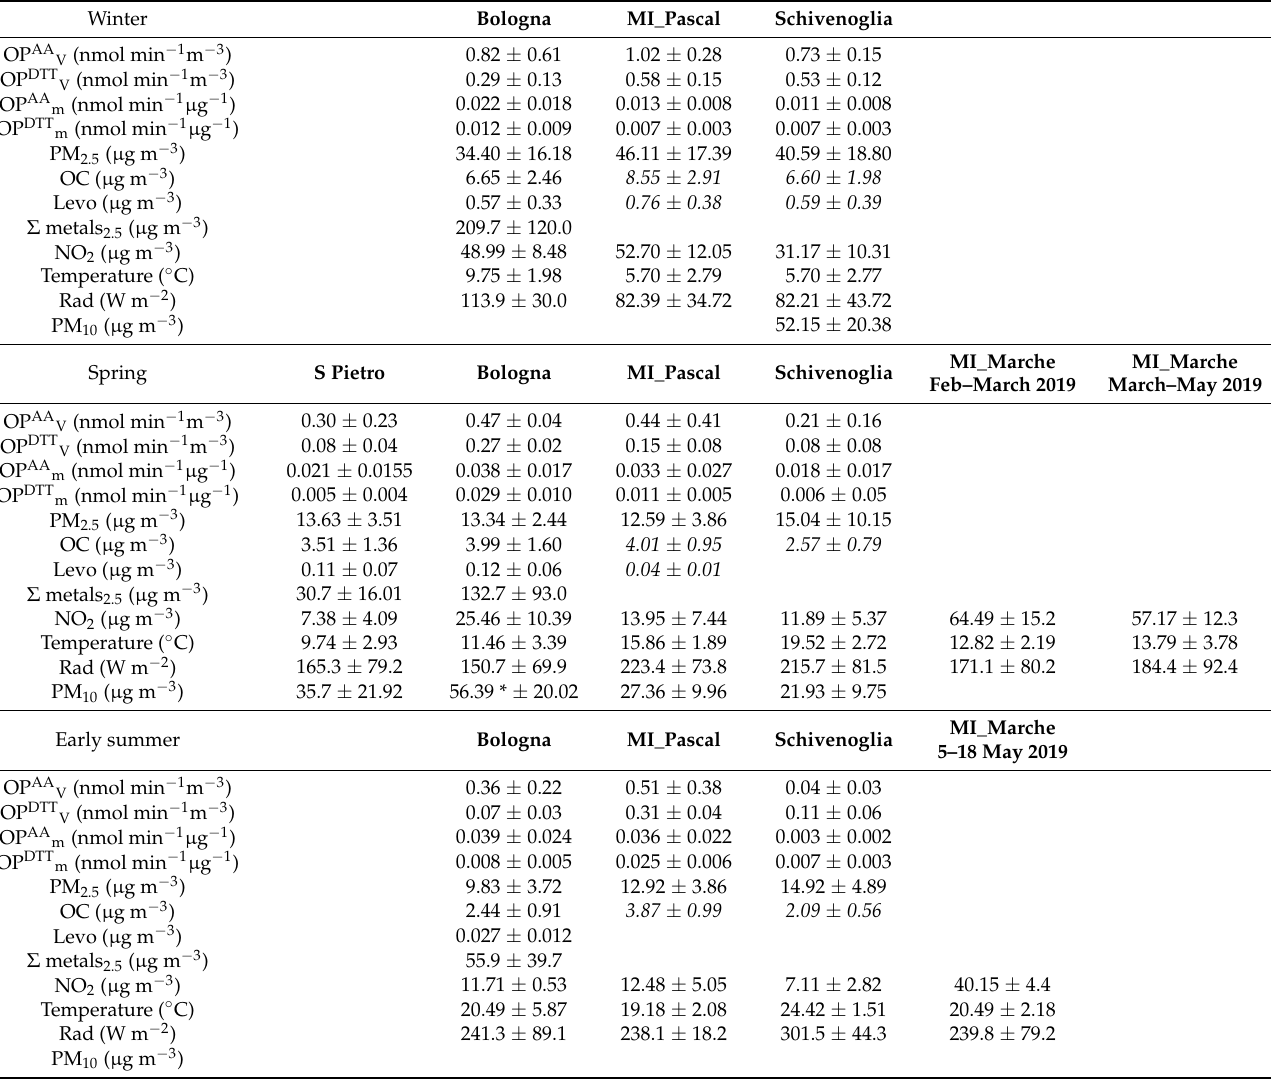
Table 4. The OP responses measured with AA and DTT assays, concentrations of PM 2.5 mass and their chemical components, air levels of nitrogen dioxide, NO 2 , meteorological parameters (ambient temperature and solar radiation). Reported values are means ± standard deviation values computed for each sampling campaign described in Table 3. * indicate means with significant differences (Student t -test at p ≤ 0.05) between the periods. BLQ = below quantification limit. Italic values indicate estimated values from data experimentally measured on PM 10